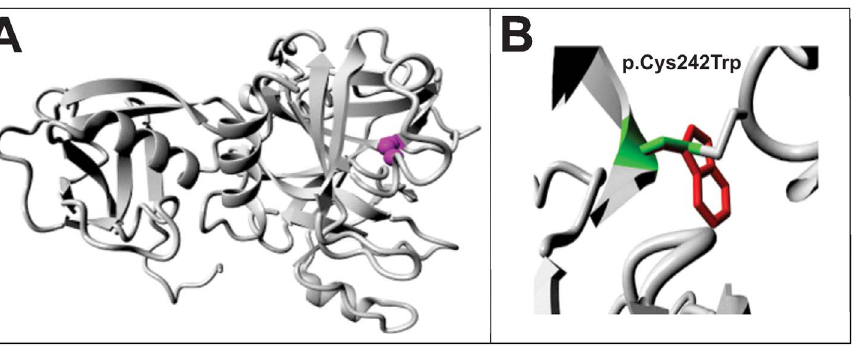
Figure 4. Predicted effect of mutation c.726C . G (p.Cys242Trp) on the three dimensional structure of TMPRSS3. A) Wild type protein structure with an intact disulphide bridge showing position of the mutated residue (magenta). B) Close-up view of the structure showing the wild type residue cysteine (green) and the mutant residue tryptophan (red). In case of the mutant residue there will be no disulphide bridge at this position.